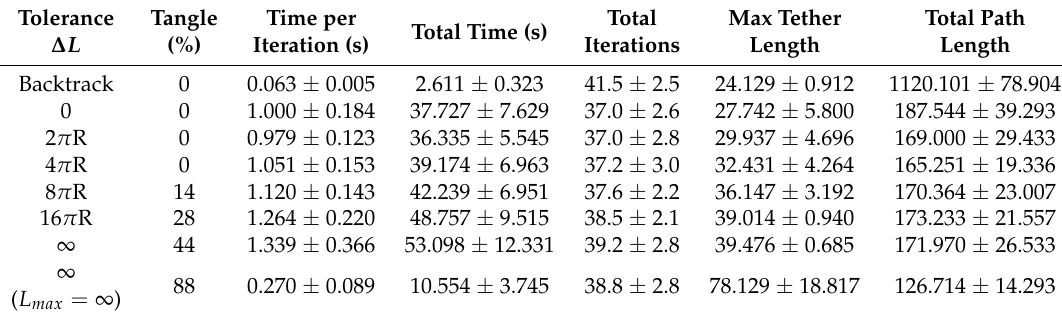
Table 1. Simulation data for low density environment. 20 × 20 map, 0.5 resolution, tether length 40, 15–20 obstacles of radius up to 2. Tether base is at [1, 1], and the field of view is set to